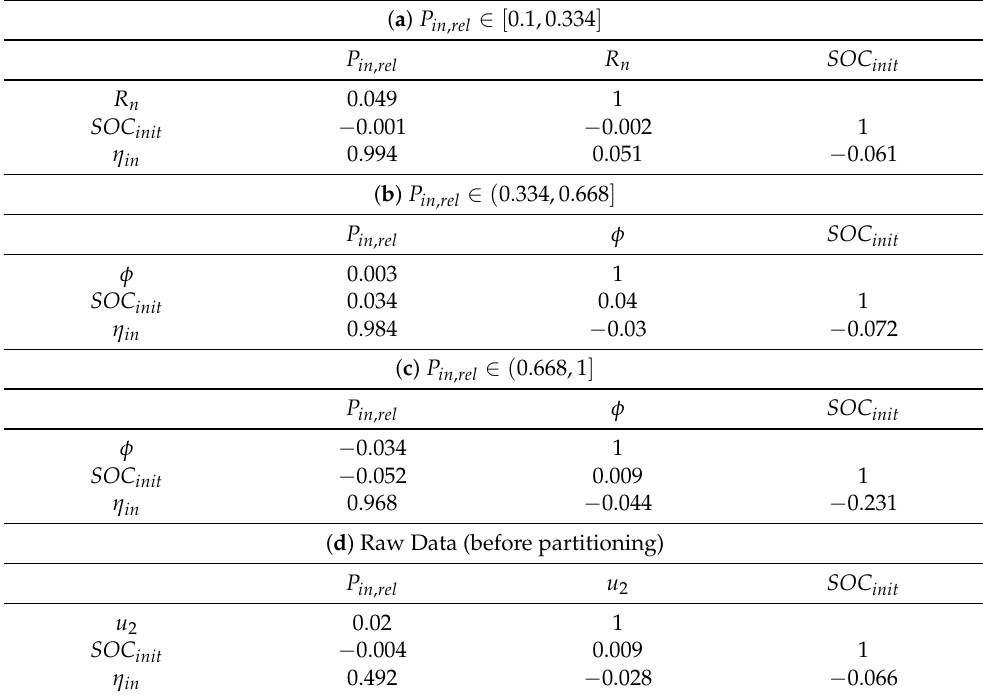
Table 5. Correlation matrices for the three partitioned data sets P in , rel ∈ [ 0.1,0.334 ] | ( 0.334,0.668 ] | ( 0.668,1 ] and the raw data set, based on the highest absolute Pear- ( i ) | of a (screened) variable x with η ∈ { 1,2,3 } son correlation coefficients | r in in data set i x ( i ) , η in